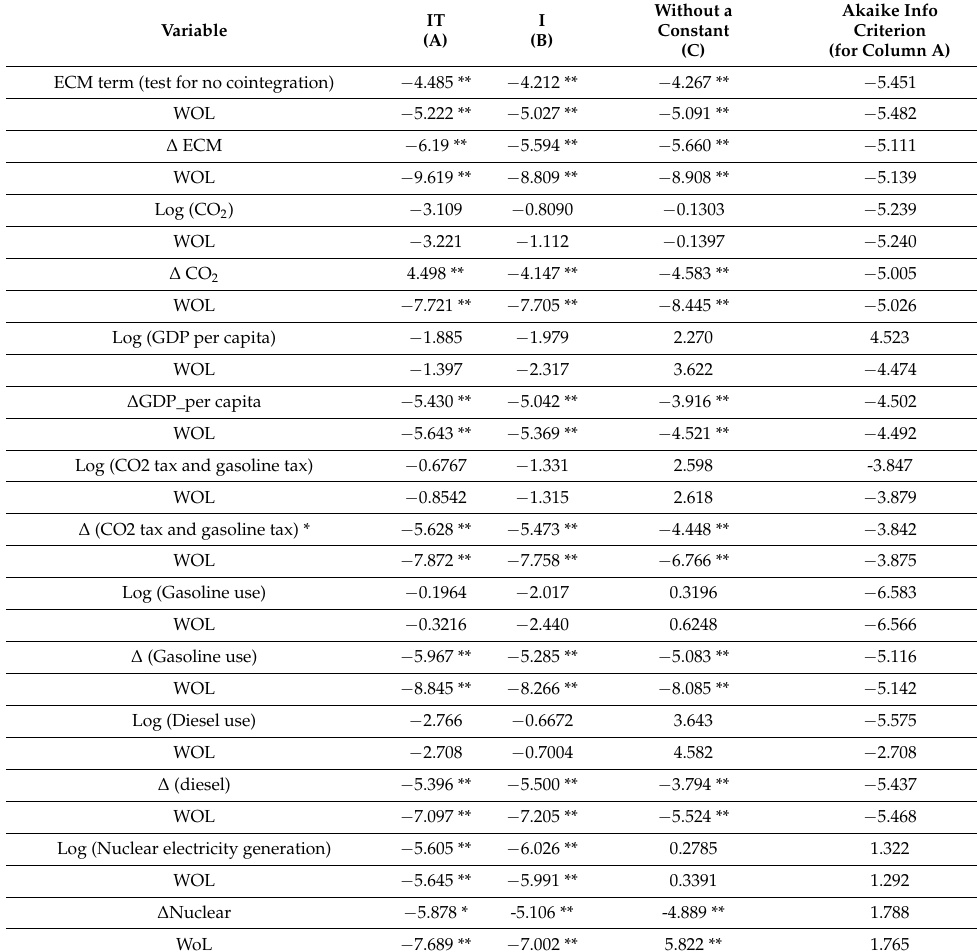
Table 7. Sample: Sweden